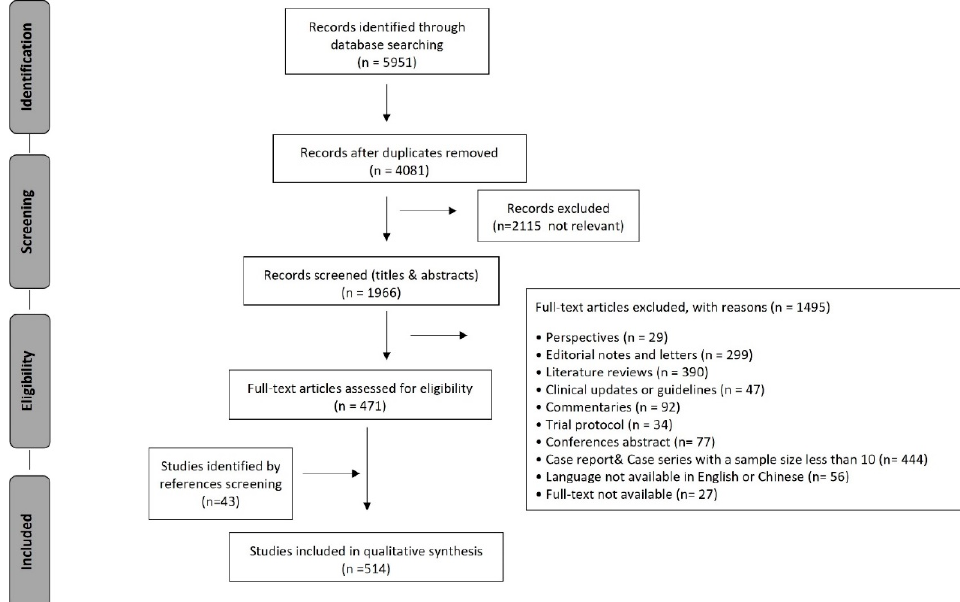
Figure 1. PRISMA Chart.